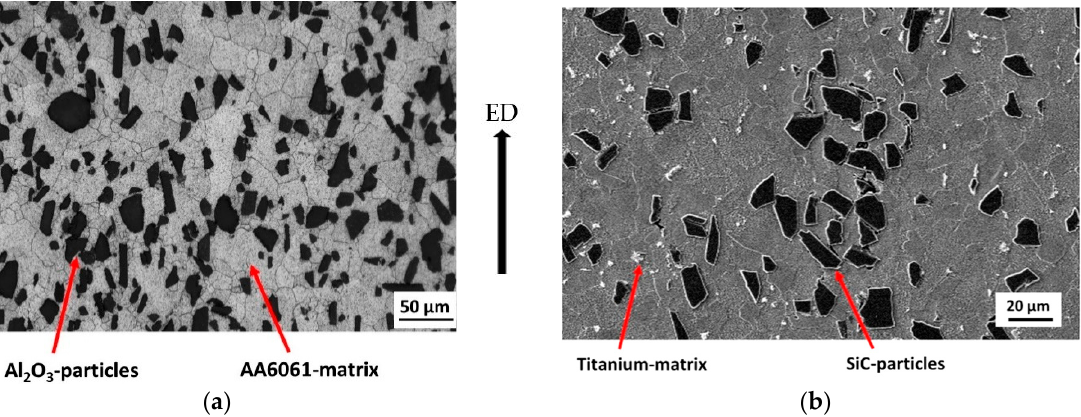
Figure 3. Longitudinal section, parallel to extrusion axis: ( a ) Al-MMC (LM); ( b ) Ti-MMC (SEM) .